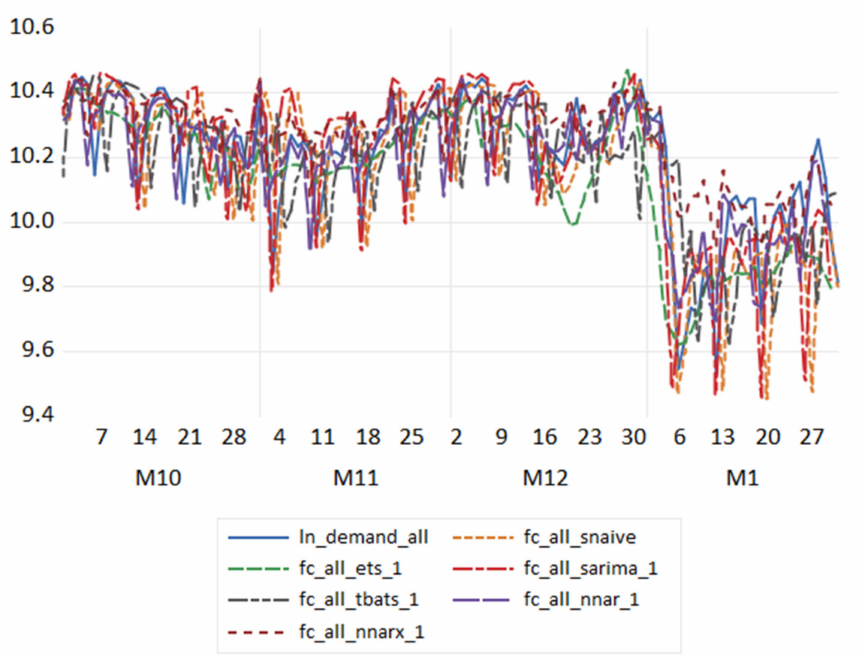
Figure 4. Historical data (solid line) and forecast comparison graph of all forecast models for hotel class ‘all’ and h = 1 for the period from 1 October 2019 to 31 January 2020. Source: STR SHARE Center, own illustration using EViews Version